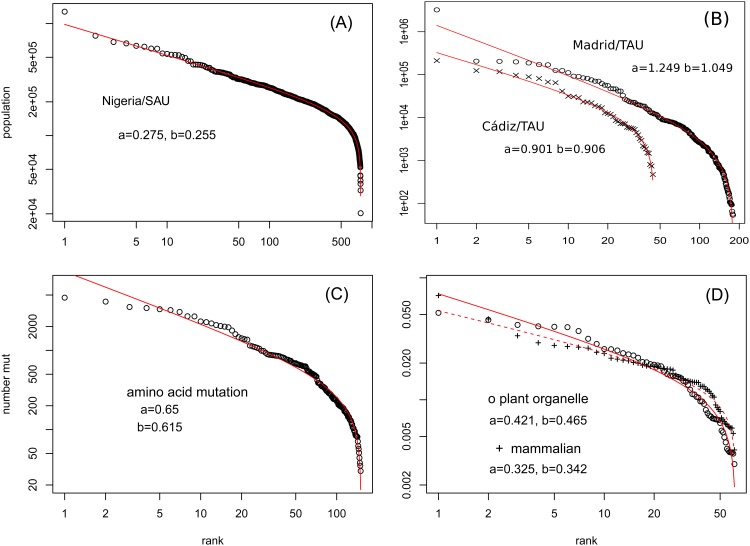
Ranked datasets fitted by Lavalette rank function.(A) Nigeria (NRG) local government area (the secondary administrative unit (SAU)) population; (B) Madrid and Cádiz municipality (the tertiary administrative unit (TAU)) population; (C) Amino acid to amino acid mutation counts in the 1000 Genomes Project; (D) Averaged codon usage (excluding the three stop codons) of plant organelles and mammals.